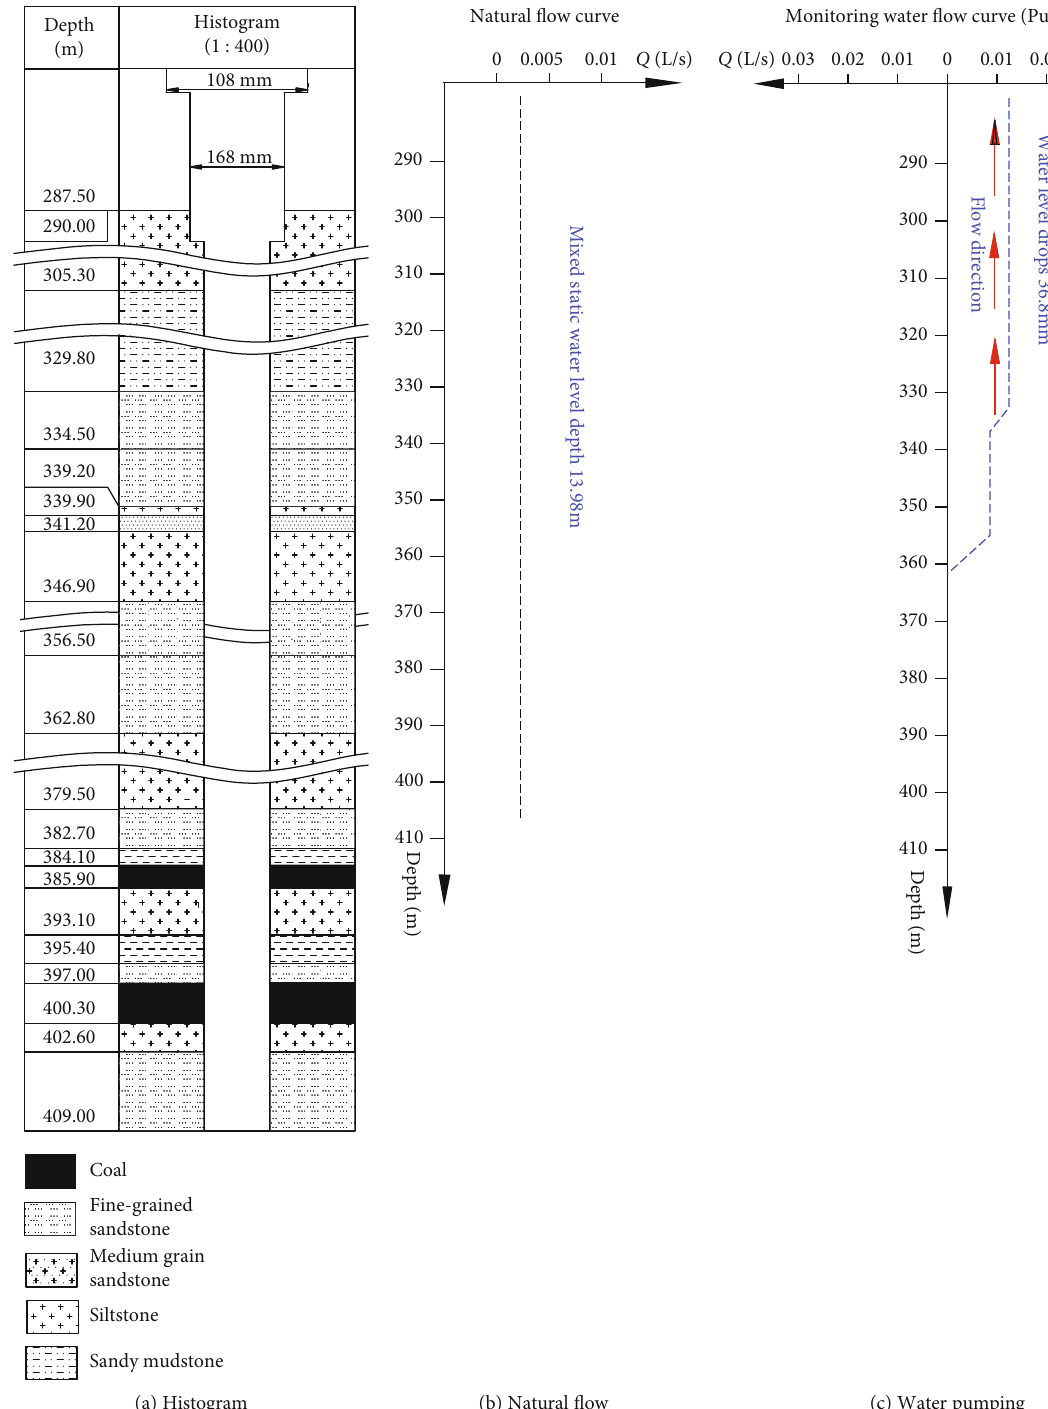
Figure 8: Flow curve diagram of the auxiliary shaft detection